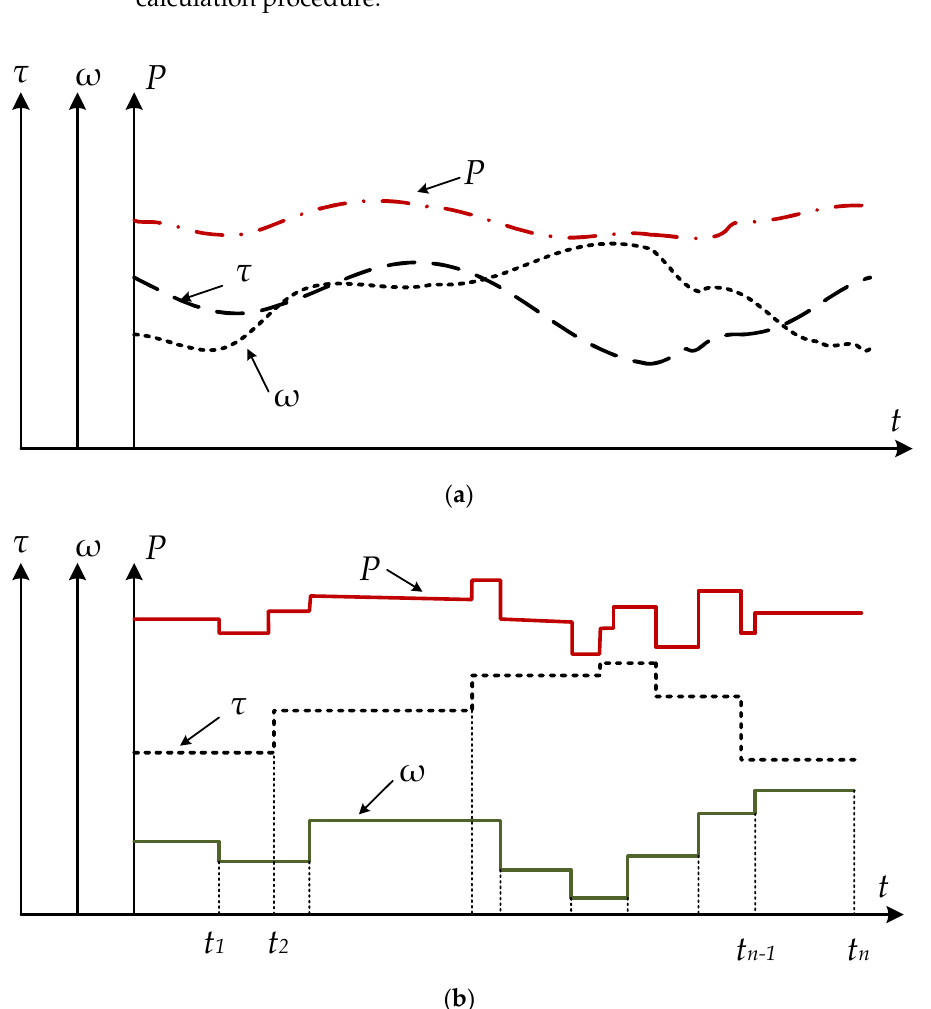
Figure 1. Cycling diagram of drive parameters: torque ( τ ), rotation speed ( ω ), and required power ( P ); ( a ) parameter curves are continued; ( b ) curves are digitized for n-segments of a time.